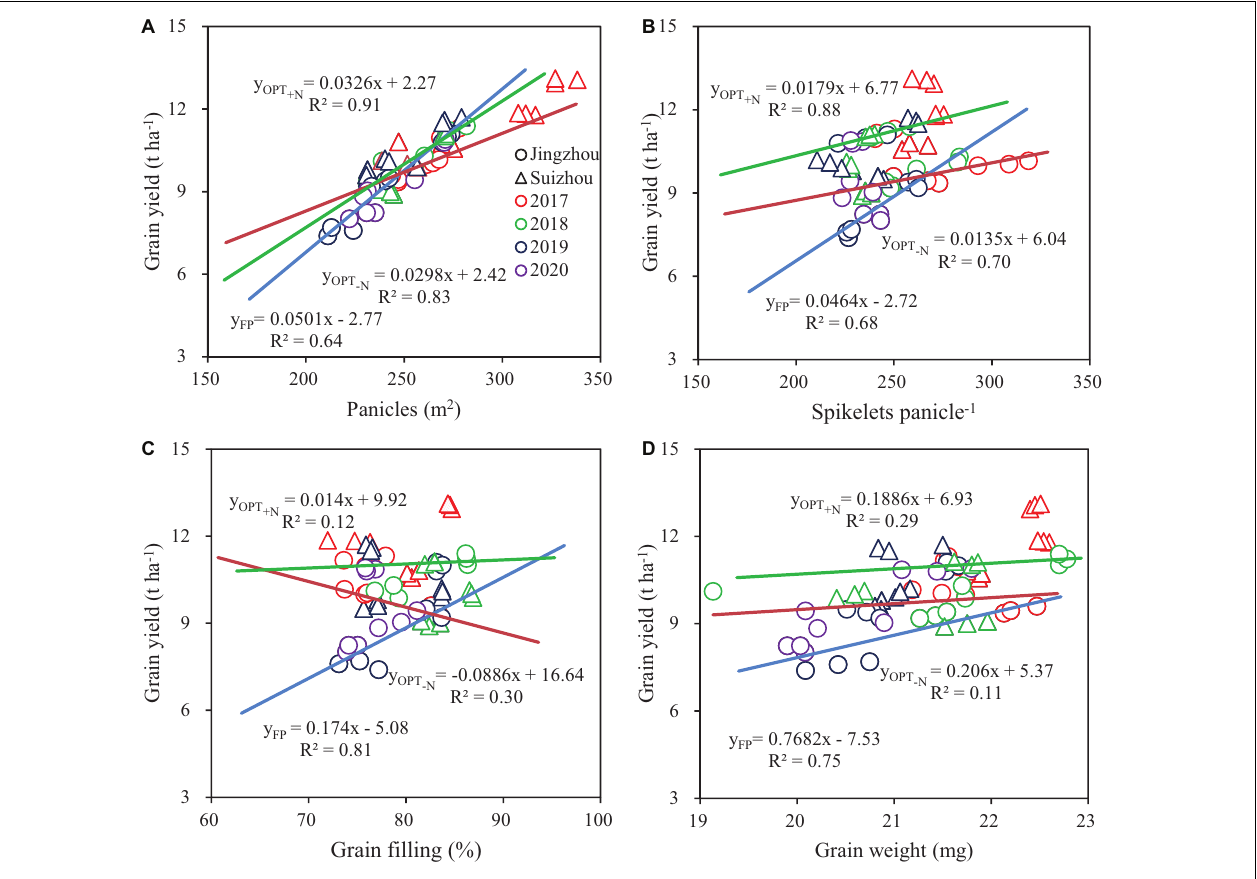
FIGURE 1 | Relationships between grain yield and panicle number (A) , spikelets per panicle (B) , grain filling (C) , and grain weight (D) . Colors and point symbols represent different years and sites, respectively.